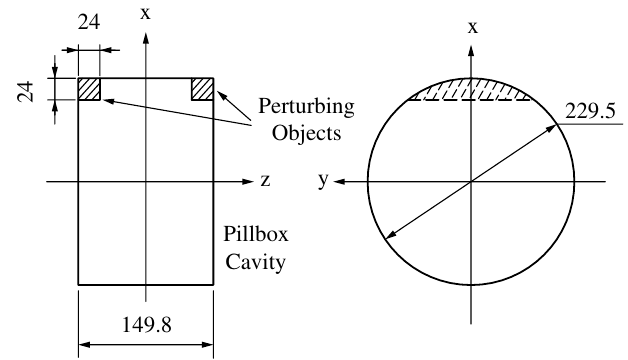
FIG. 5. Second example of a perturbed cavity. Two metallic objects are attached on one ( x > 0 ) side of the pillbox cavity.